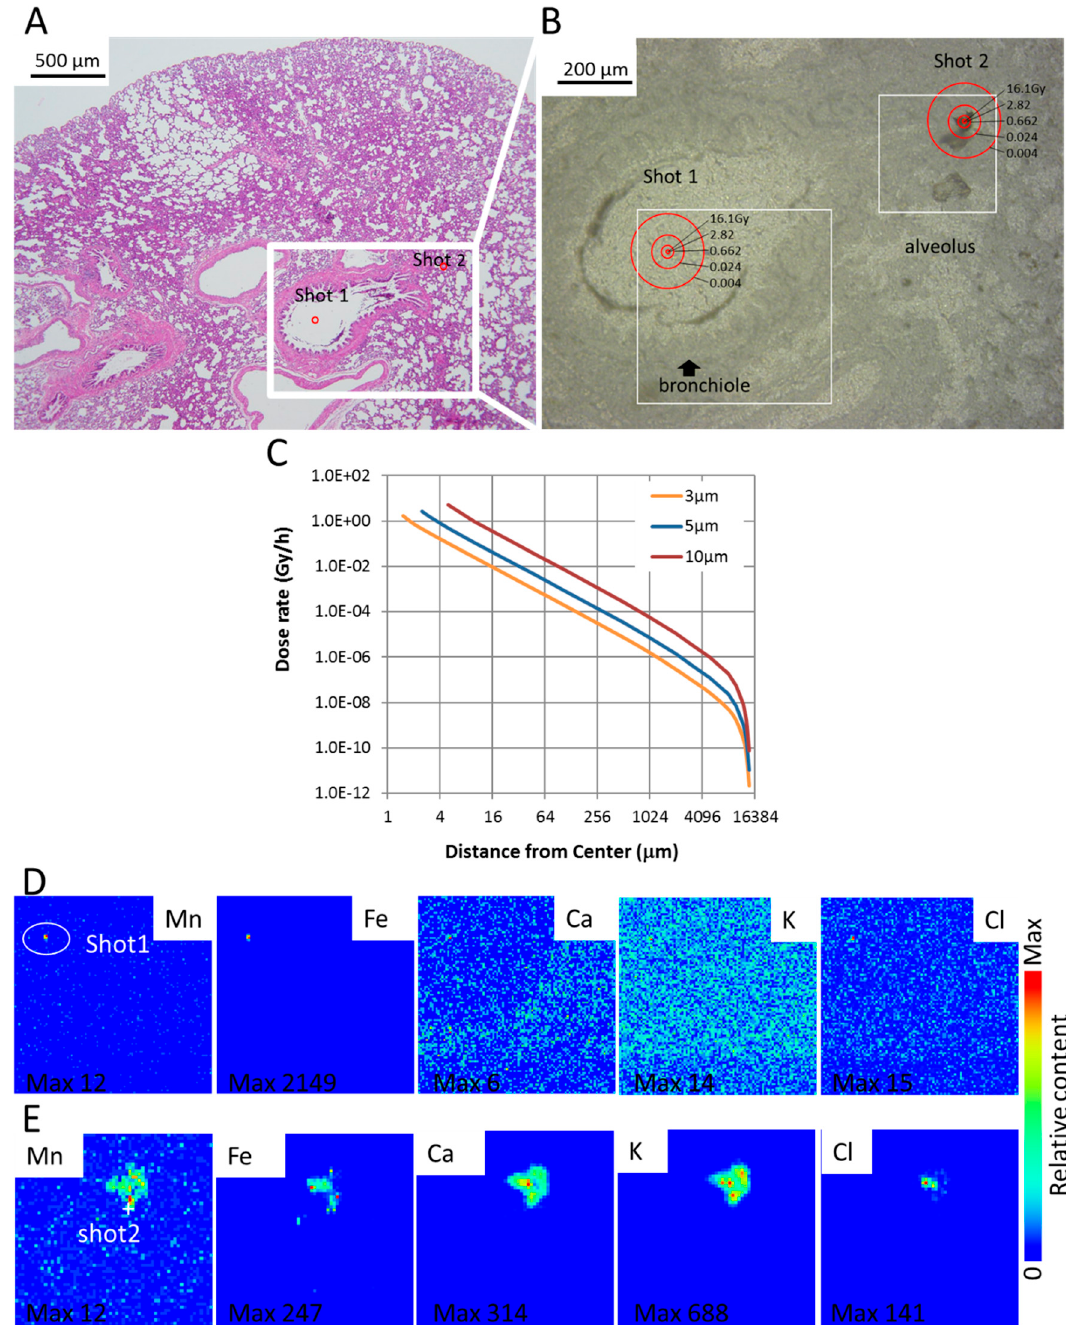
Figure 5. Early elementary profile, histopathologic image and electron dose rate in lung tissue 6 h after 56 Mn(2×) internal exposure. ( A ) Shot1, located in the bronchiole cavity and Shot2, located in the damaged tissue of the alveolus are observed particles of manganese and iron. H&E stain, 4× objective magnification; ( B ) As can be seen, a 5-µm-diameter particle has a 5.4-Gy/h absorbed dose rate immediately following intake and 16.1-Gy accumulated dose for 6 h at 2.5 µm measured from the center; ( C ) dose rate for 56 Mn. The dose rate depended on the diameter of the particle (3, 5 and 10 µm). Larger diameter particles showed higher dose rate. Elementary imaging (beam size: 1 µm × 1 µm) of Shot1 ( D ) (5 µm step, 500 × 500 µm) and Shot2 ( E ) (5 µm step, 300 × 300 µm) of boxed areas marked in ( B ) are shown. Maximum concentrations are Shot1; Mn 2900 µg/g, Fe 530,000 µg/g and Shot2; Mn 2900 µg/g, Fe 61,000 µg/g. Corresponding serial section stained with H&E ( A ) and converted to grayscale is shown in ( B ).